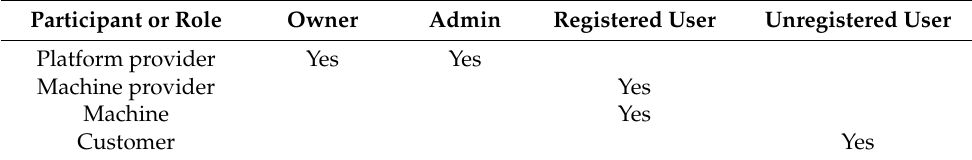
Figure 1. Use case diagram of actors and activities. Table 1. System participants and their foreseen smart contract